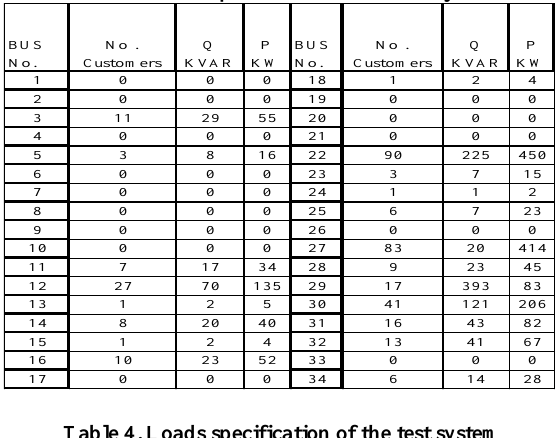
Table 4. Loads specification of the test